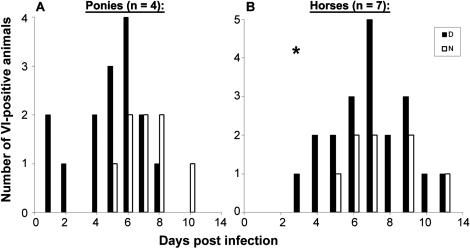
Viral Isolation from PBMC/RK13 Coculture ExperimentsVirus was isolated during the equine experimental infection studies with the revertant pol genotype virus (D752, •) and mutant virus (N752, ○). *p < 0.05.The number of culture-positive animals are shown, out of four total ponies per group (A) and seven total horses per group (B).